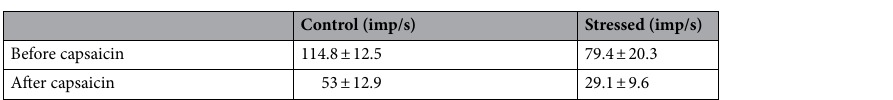
Table 1. Maximum nerve activity recorded in bladders from control and stressed mice during distension to 40 mmHg before and after application of Capsaicin (100 µM). Mean ± SEM from n ≥